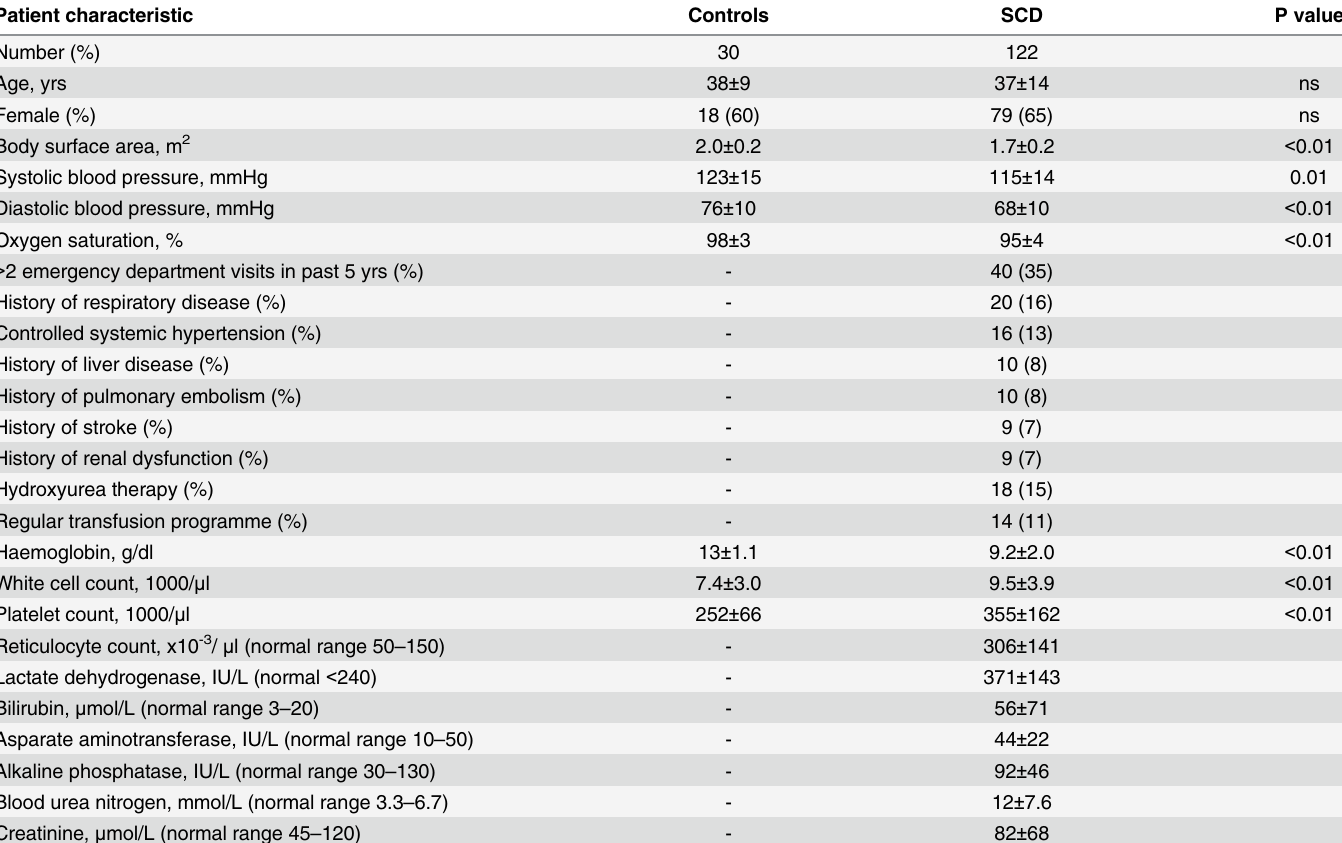
Table 1. Clinical characteristics of SCD patients compared with matched control